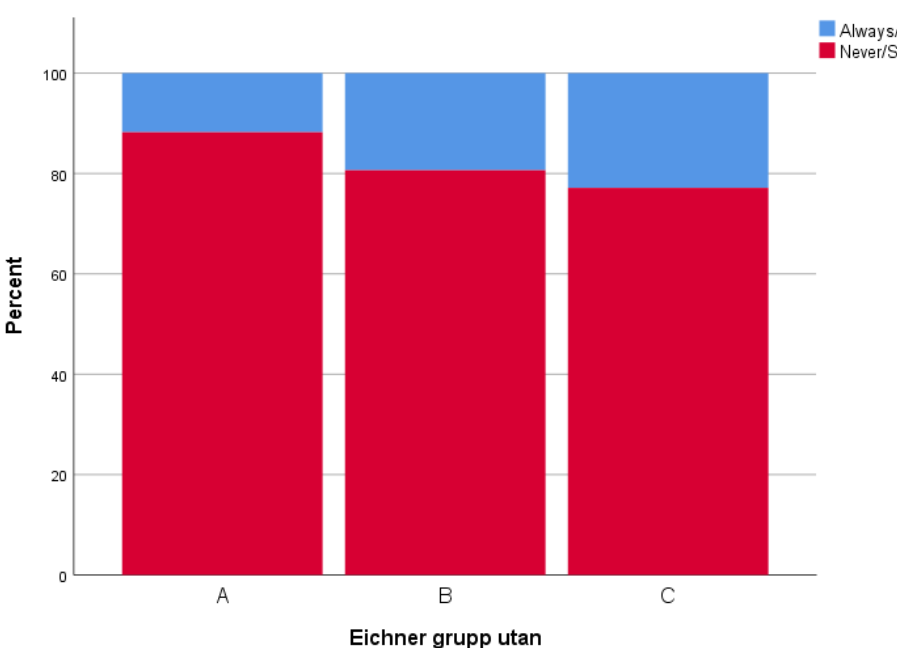
Figure 2. How often did you limit the kinds or amounts of food you eat because of problems with your teeth or dentures? Participants grouped according to the Eichner index, which measures number of occluding teeth. ( A ) = four occluding zones, ( B ) = one to three occluding zones or presence of occlusal contacts frontally, and ( C ) = no occluding teeth.